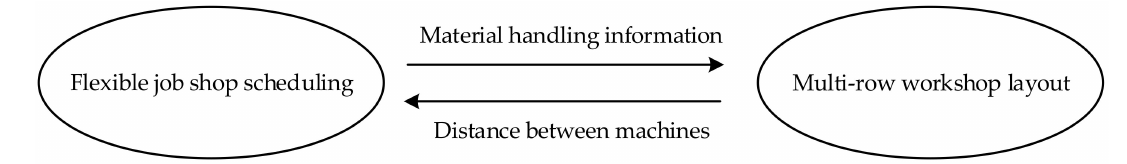
Figure 1. Relations between FJSSP and